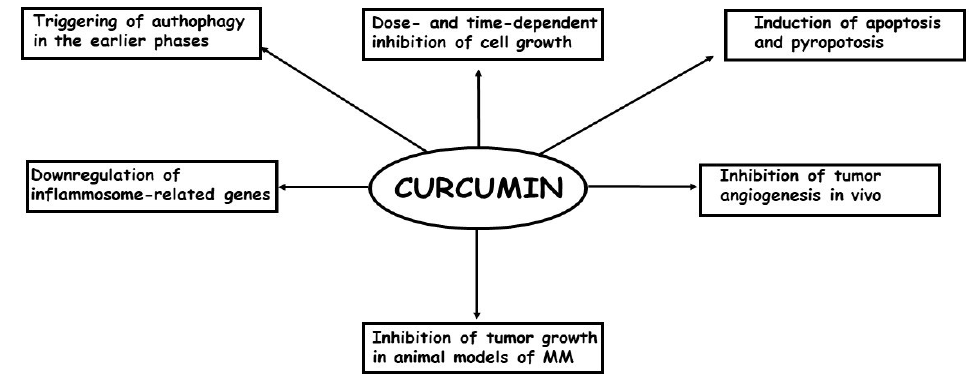
Figure 2. The most important in vitro and in vivo e ff ects of curcumin in MM cells are